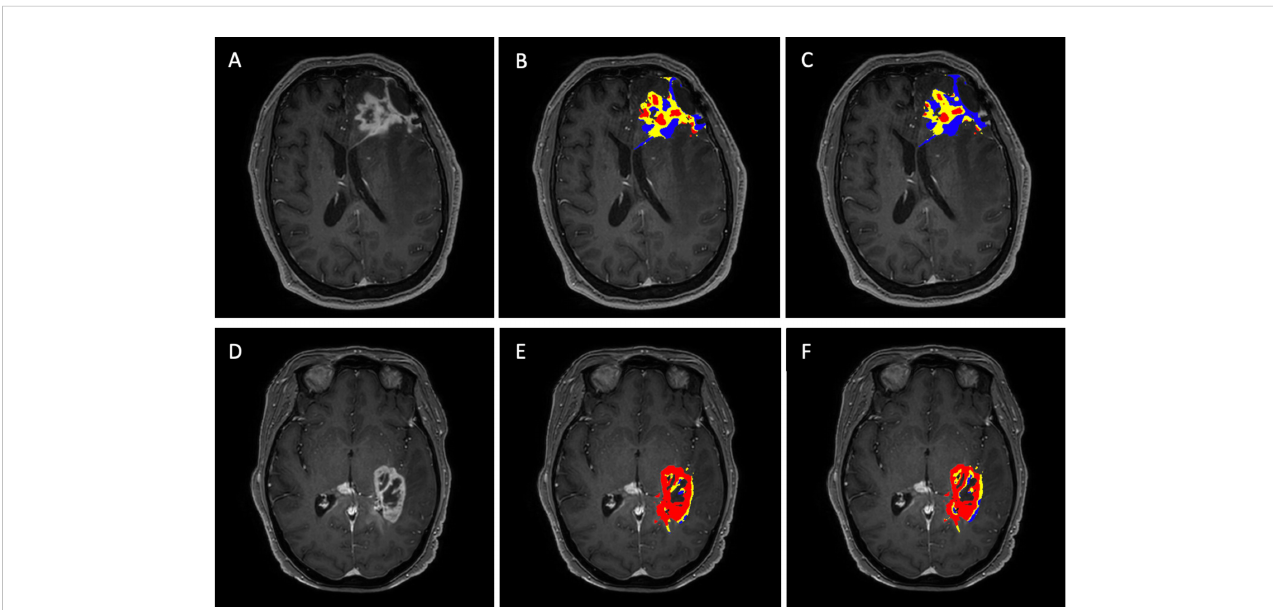
FIGURE 4 FTB maps generated for the single-dose, dual-echo and double-dose, single-echo protocol for two separate patients with the anatomical post-contrast T1 – weighted images in the far-left column (A, D) . Patient (A – C) is a 58-year-old male with grade IV glioblastoma presenting 11 months after the stereotactic radiosurgery. Patient (D – F) is a 65-year-old female with grade IV glioblastoma presenting 4 months after biopsy. The middle column corresponds to the FTB maps (B, E) generated for the single-dose, dual-echo protocol. The far-right column corresponds to the FTB maps (C, F) generated from the standard reference double-dose, single-echo protocol. The standard thresholds of 1 and 1.75 were used for both protocols. Blue represents areas of PTRE, yellow and red represents tumor with moderate and high angiogenesis,